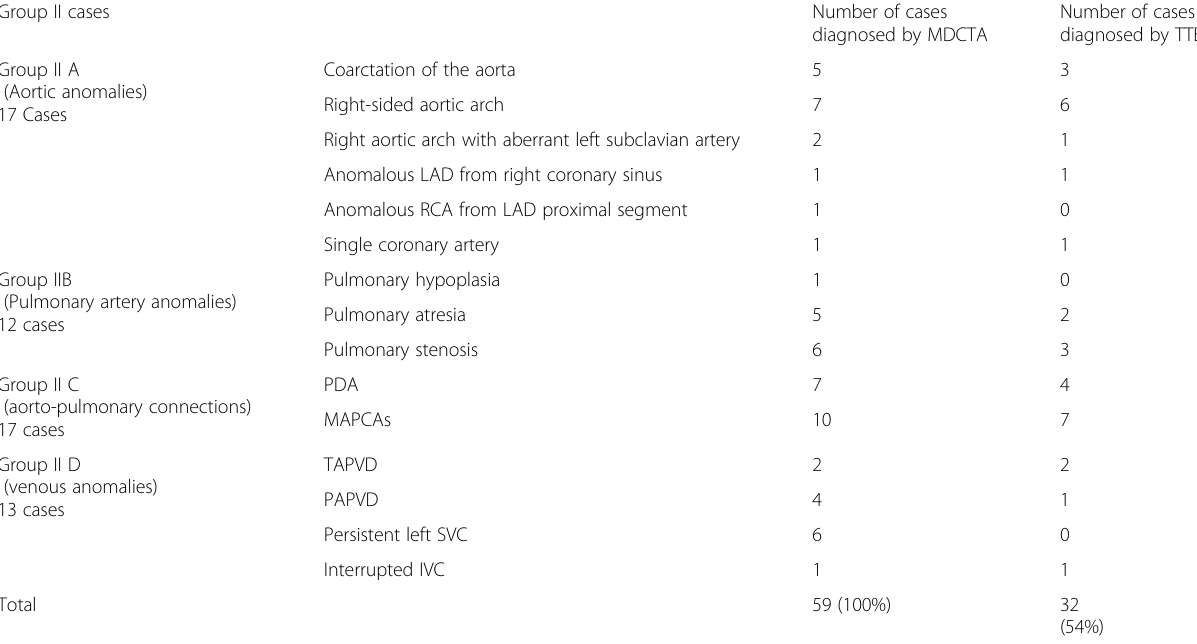
Table 2 Detection of extra-cardiac major vessels anomalies in group II by MDCTA and TTE